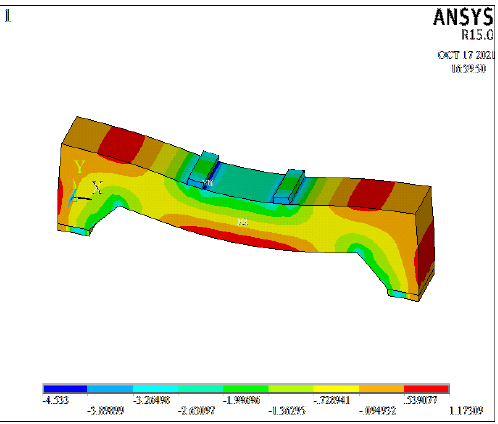
Figure 9. Contour of the hydrostatic stress for the typical non-prismatic RC beam model B1 (solid).